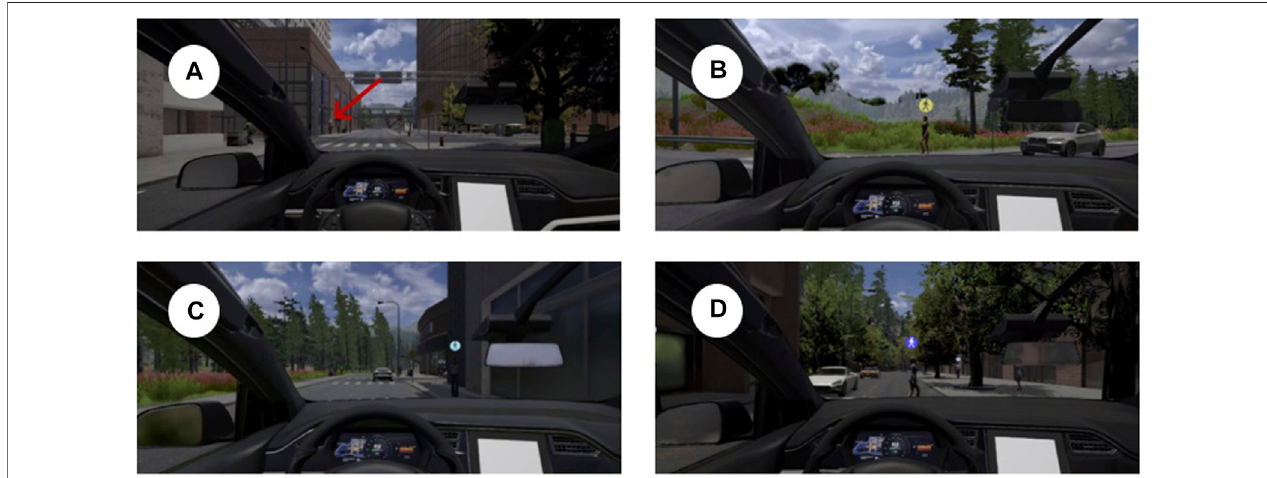
FIGURE 1 | System states for visualizing pedestrians ’ intention, (A) circle not colored when pedestrian is recognized but still too far away, (B) yellow circle when pedestrian is recognized but intention is unclear, (C) light blue circle when pedestrian is recognized and intention is clear: “ stay, ” (D) dark blue circle when pedestrian is recognized and intention is clear: “ cross.